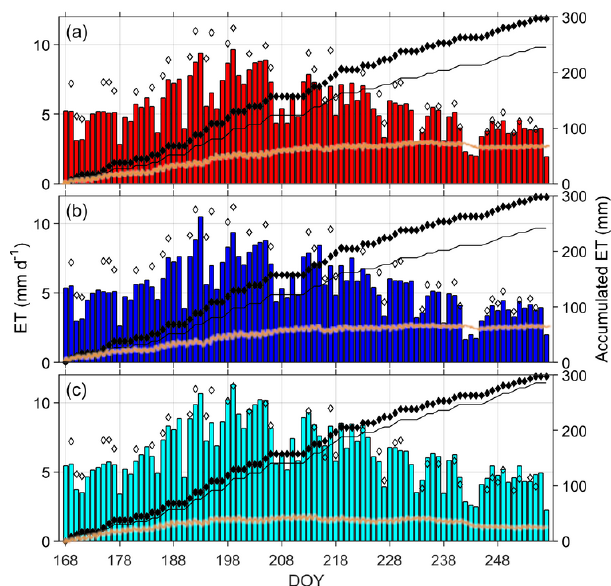
Figure 7. Daily ET determined with (a) LI-7500RS (red), (b) LI- 7500A (blue), and (c) LI-7500 (cyan). The daily lysimeter ET is displayed by open diamond markers. Accumulated lysimeter ET is shown with solid diamonds and accumulated eddy covariance ET measurements with solid lines. Accumulated daily residual energy is in orange circles. Final accumulated energy balance residuals, computed by subtracting eddy covariance ET from the other ma- jor energy balance terms ( R n − H − G ) of each day, for these EC systems (mm) are 66.6, 63.3, and